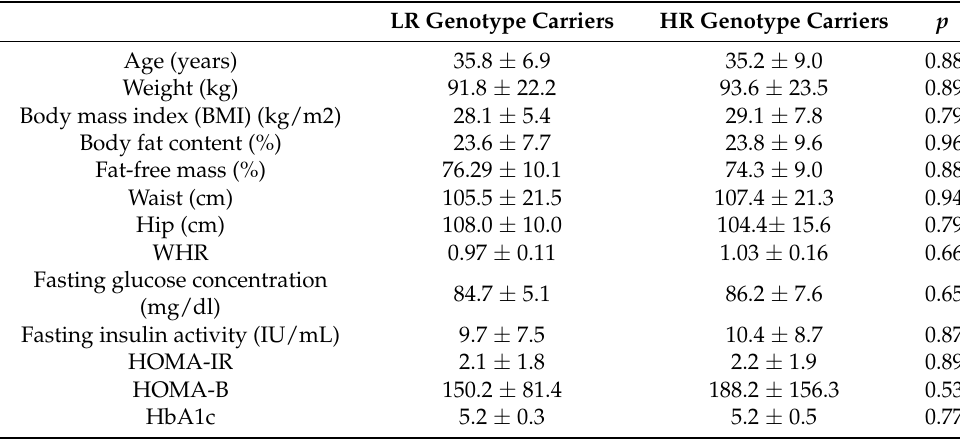
Table 1. Baseline characteristics of the study groups.